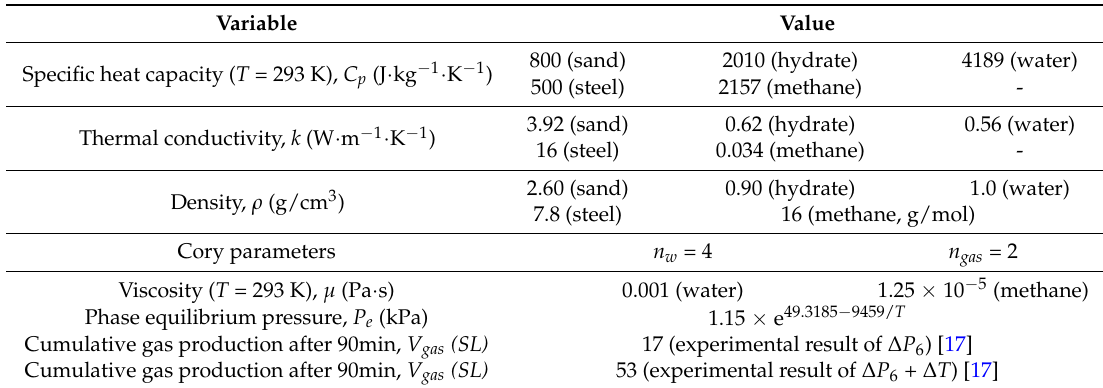
Figure 1. Schematics of the ( a ) simulated region; and ( b ) the computational grid of hydrate dissociation. Table 2. Physical parameters used in the numerical simulation.